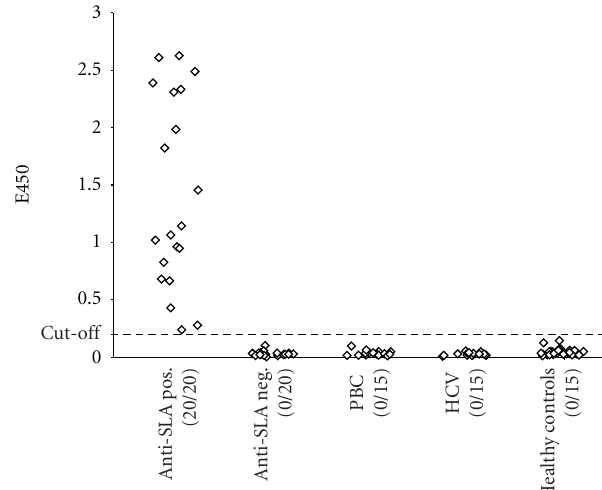
F 2: Autoantibodies against SLA detected with ELISA based on bacterially expressed protein. Bacterially expressed SLA (SLA- His-coli) was used to form the solid phase in an indirect ELISA for the determination of human IgG antibodies in 20 anti-SLA positive autoimmune hepatitis sera, 20 anti-SLA negative autoimmune hepatitis sera, 15 primary biliary cirrhosis sera, 15 HCV sera, and 30 sera from healthy blood donors. Positive and total numbers of sera are given below the diagrams. e cut-off value is presented by a dotted